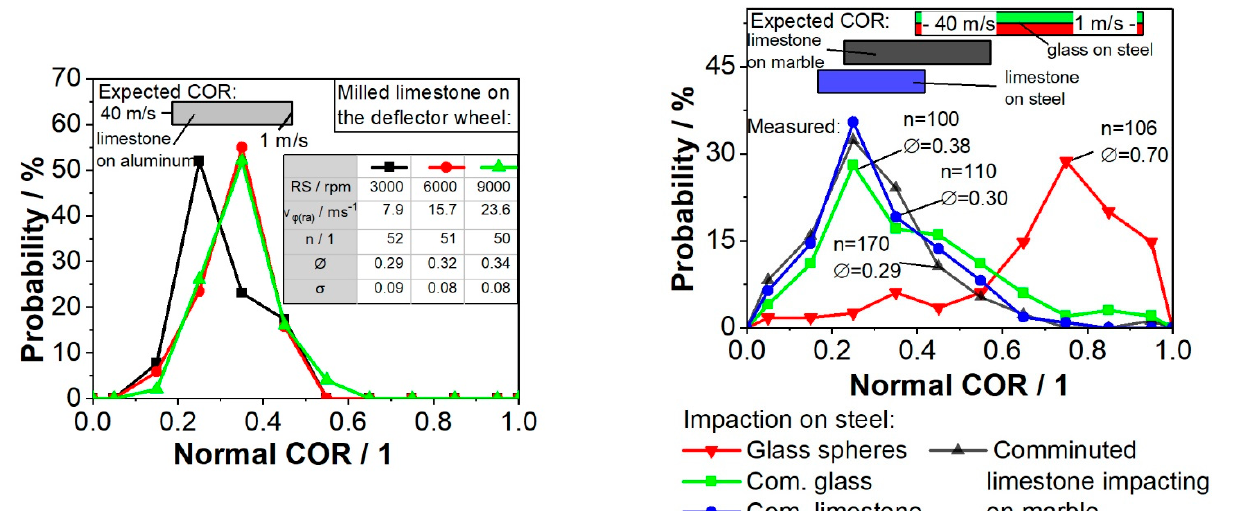
Figure 9. Normal coefficient of restitution (COR) probability distribution. ( Left ) measured in the deflector wheel classifier for limestone particles and ( right ) measured in the impact test bed for different materials. The colored bars on the top shows the range of the expected values for spherical particles impacting on a smooth wall predicted by the model of Thornton [24,25] and the literature material properties for 1 m/s to 40 m/s. RS stands for rotor speed, v ϕ (ra) for the rotor speed at the outer radius, n for the number of evaluated particles, Ø for the mean COR, and σ for the standard deviation.